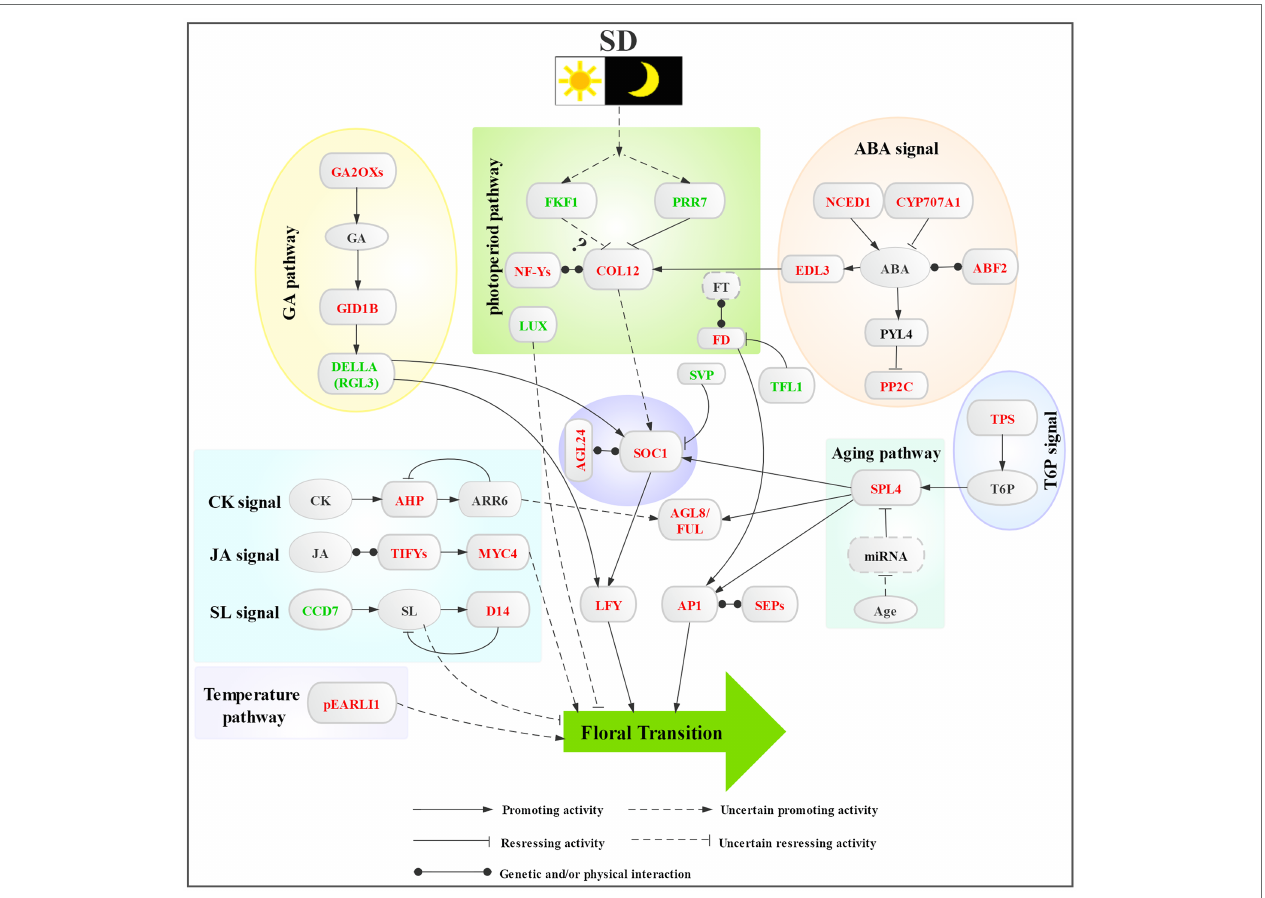
FIGURE 6 | Proposed regulatory network of short-day photoperiod-induced floral transition in L. gratissima. Colored fonts represent downregulated (green) or upregulated (red)